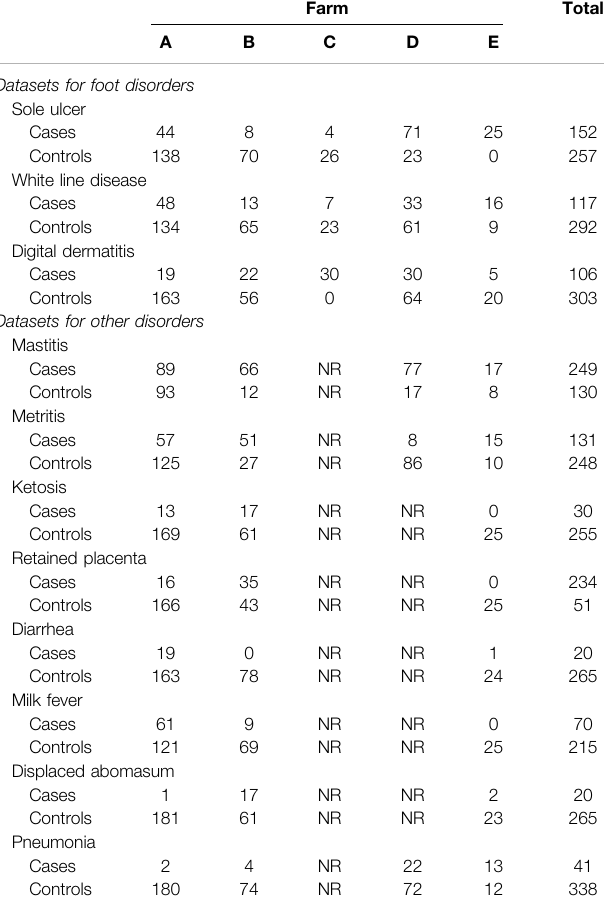
TABLE 1 | Count of genotyped cows after quality fi ltering, split by cases for each foot disorder or other health condition and controls across the fi ve dairies. Farm